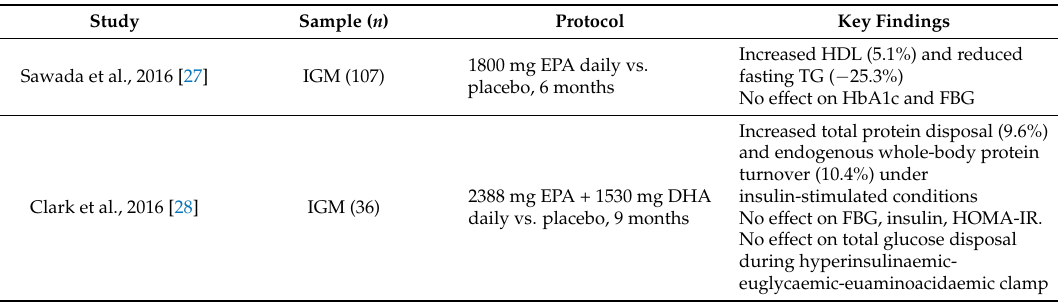
Table 2. Metabolic profile in diabetes and metabolic